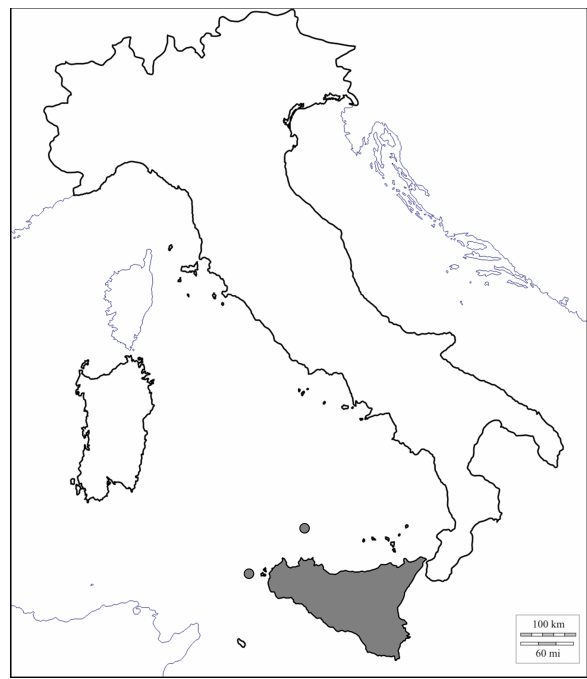
Figure 9. Distribution map of Crocidura sicula (redrawn from Sarà 2008). Sorex antinorii Bonaparte, 1840. This (Fig. 10), and marginally in southern